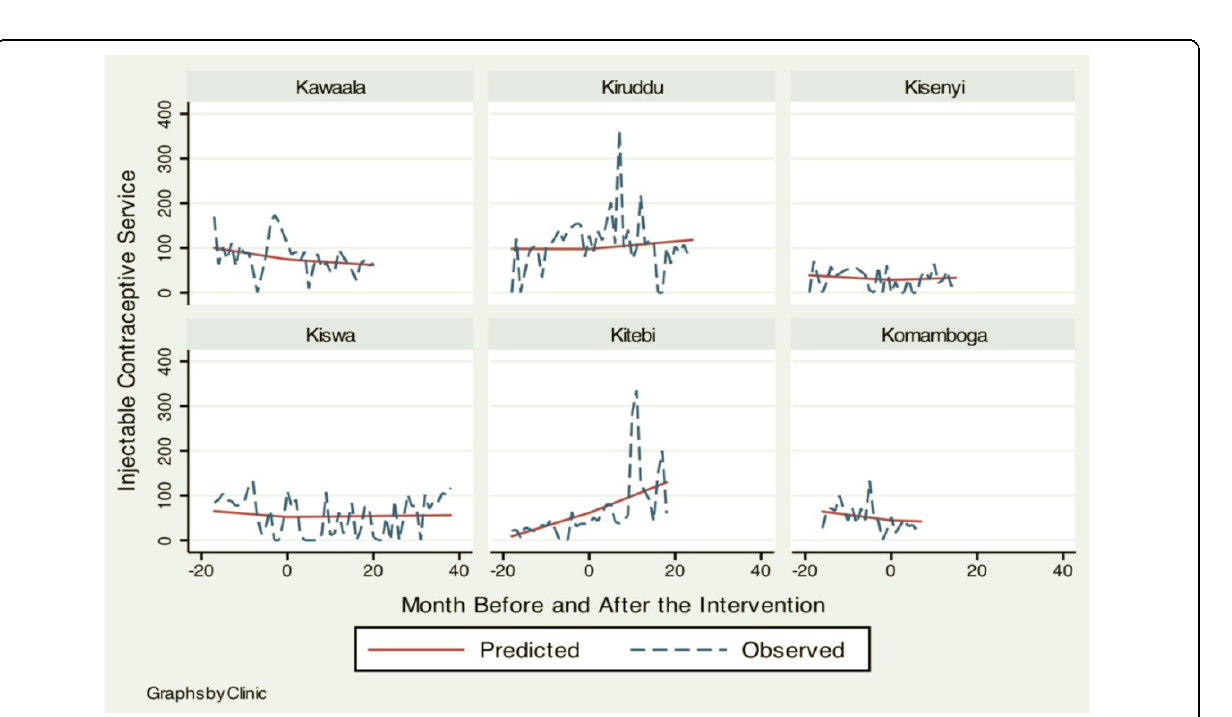
Figure 3 Fitted trends for key health services . Graphs by